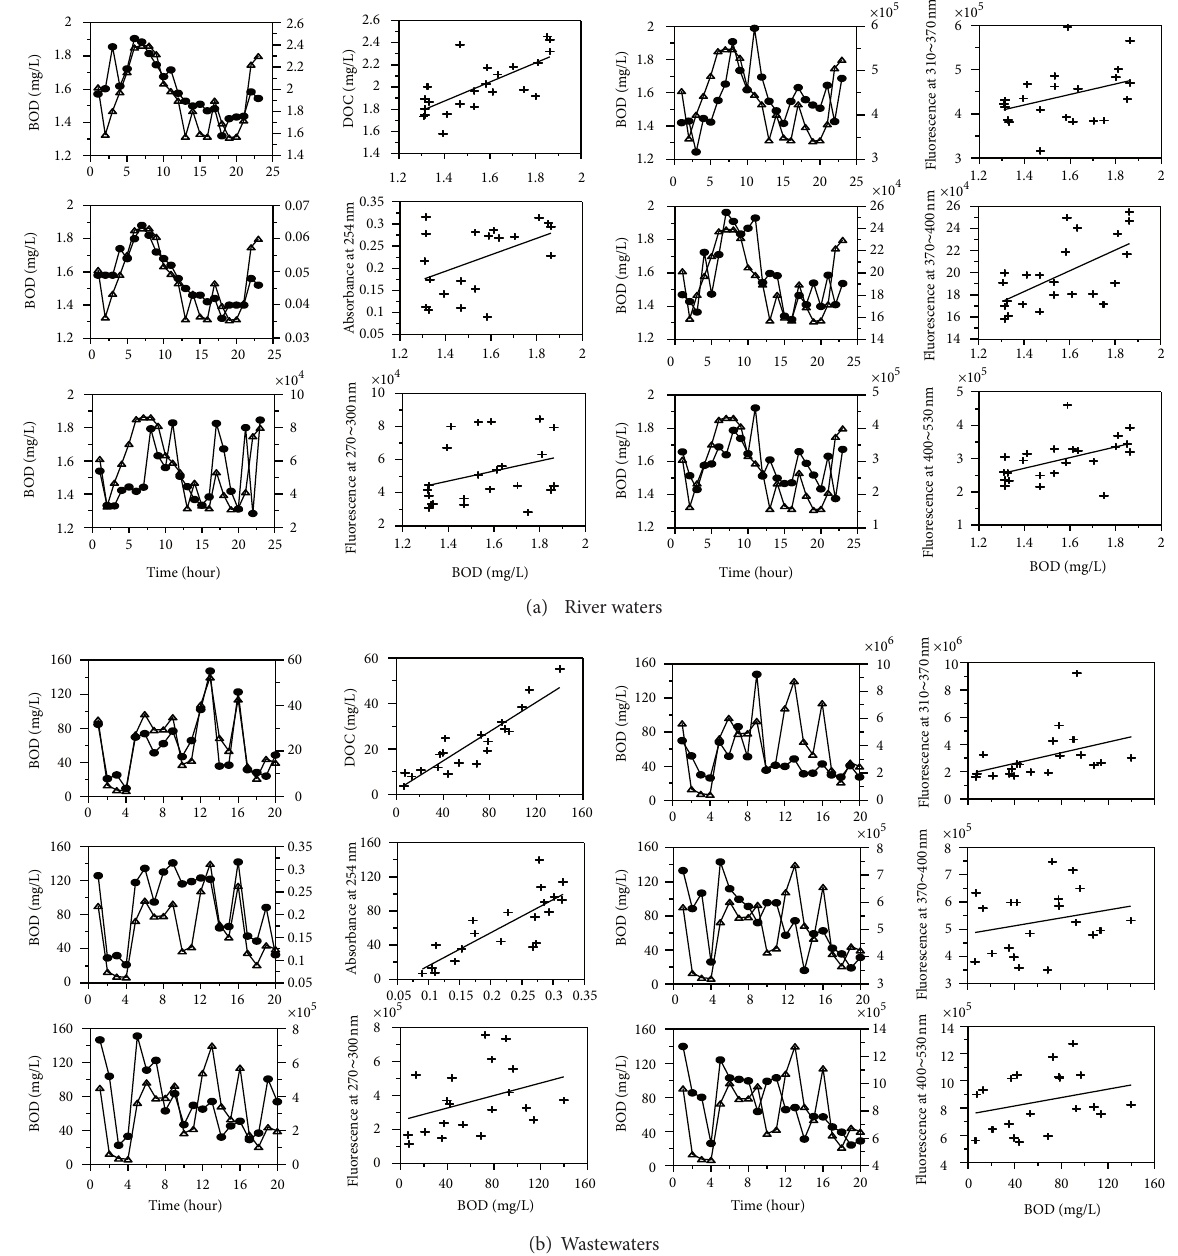
(b) Wastewaters and other parameters for (a) river waters and (b) 5